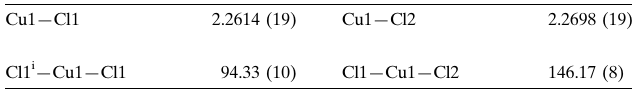
Selected geometric parameters (A˚ , (cid:2) ).